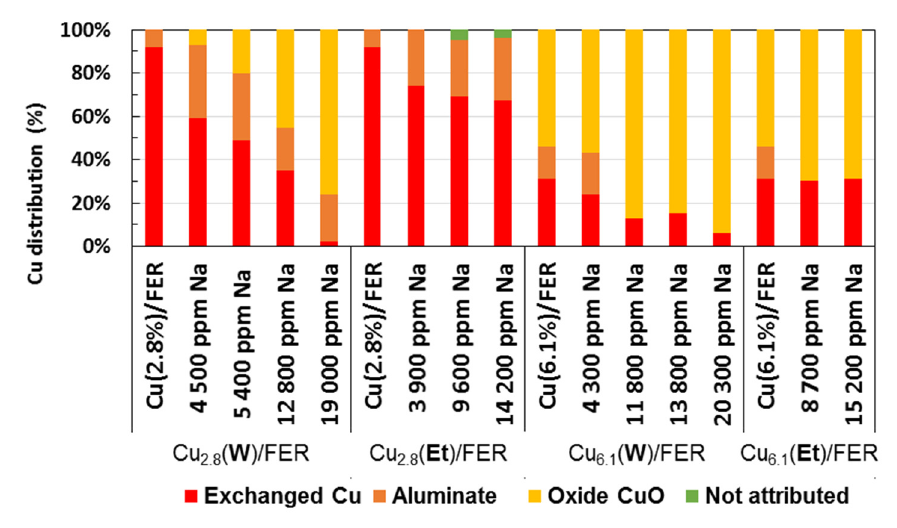
Figure 5. Copper distribution deduced from H 2 ‐ TPR experiments in function of Na impregnation solvent (water (W) or ethanol (Et)) over Cu 2.8 /FER and Cu 6.1 /FER catalysts. ( ): exchanged Cu; ( ): aluminate Cu; ( ): oxide Cu; ( ): no attributed.